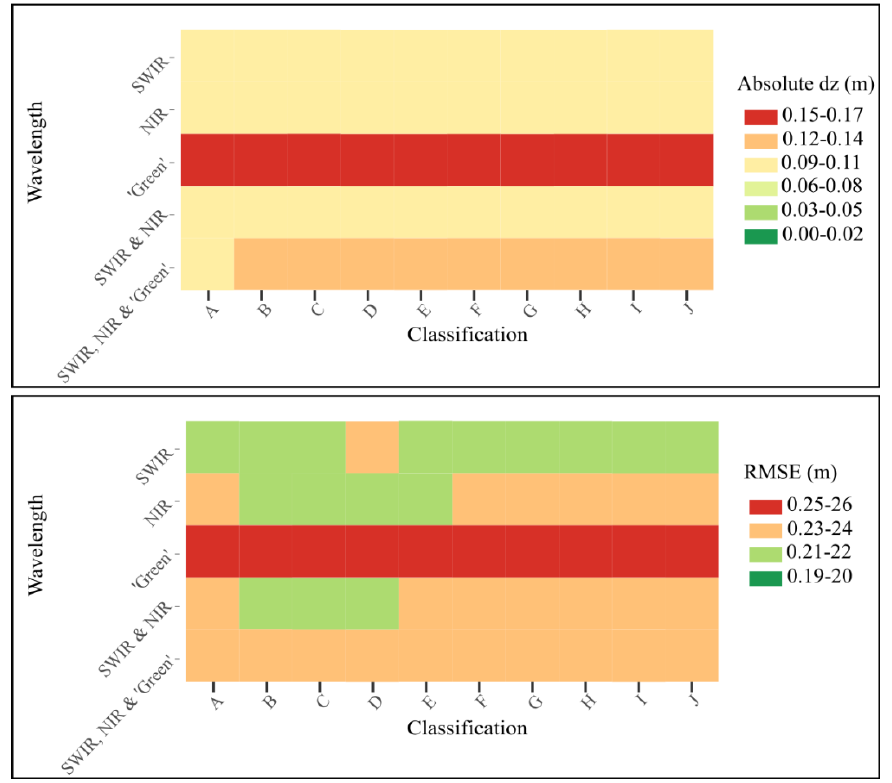
Figure 13. Ground classification results (| 𝑑𝑧̅̅̅ | and RMSE) in unburned peatlands. Classifications were conducted in LAStools.